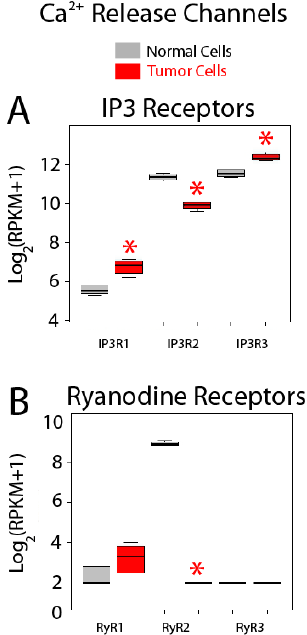
Figure 10. Expression of Ca 2+ release channels in normal and colon cancer cells. Expression levels of inositol trisphosphate receptors (IP 3 Rs) ( A ) and ryanodine receptors (RyRs) ( B ) in normal colonic cells (grey bars) and colon cancer cells (red bars). * p statistically significant by three independent methods.